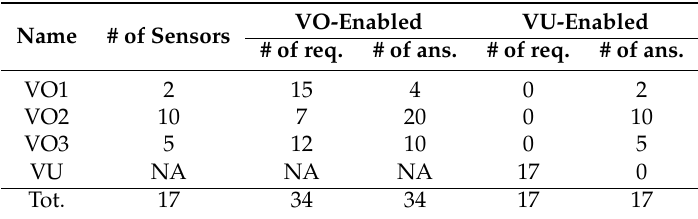
Table 2. Comparison of requests and answers to create and manage profiles using the VO-enabled and VU-enabled profiling.